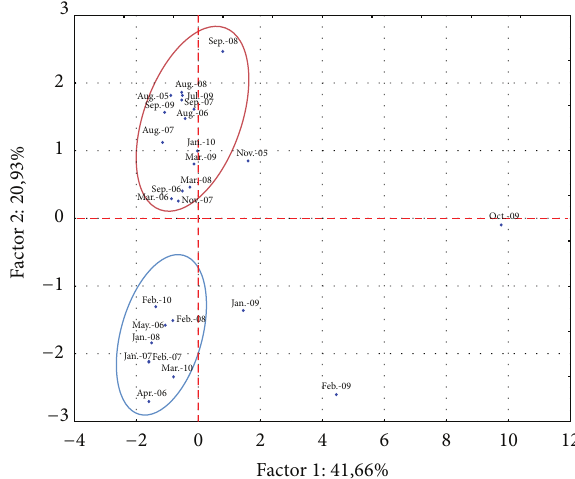
Figure 14: Average depositions of inorganic micropollutants for deposimeters D4, D5, and D6 from September 2006 to March 2009. Iron concentrations are in mg ⋅ m −2 ⋅ day −1 . Zinc concentrations are reported separately because of different